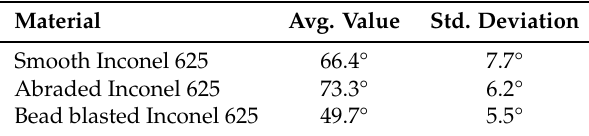
Table 6. Wettability measurement results as contact angle.